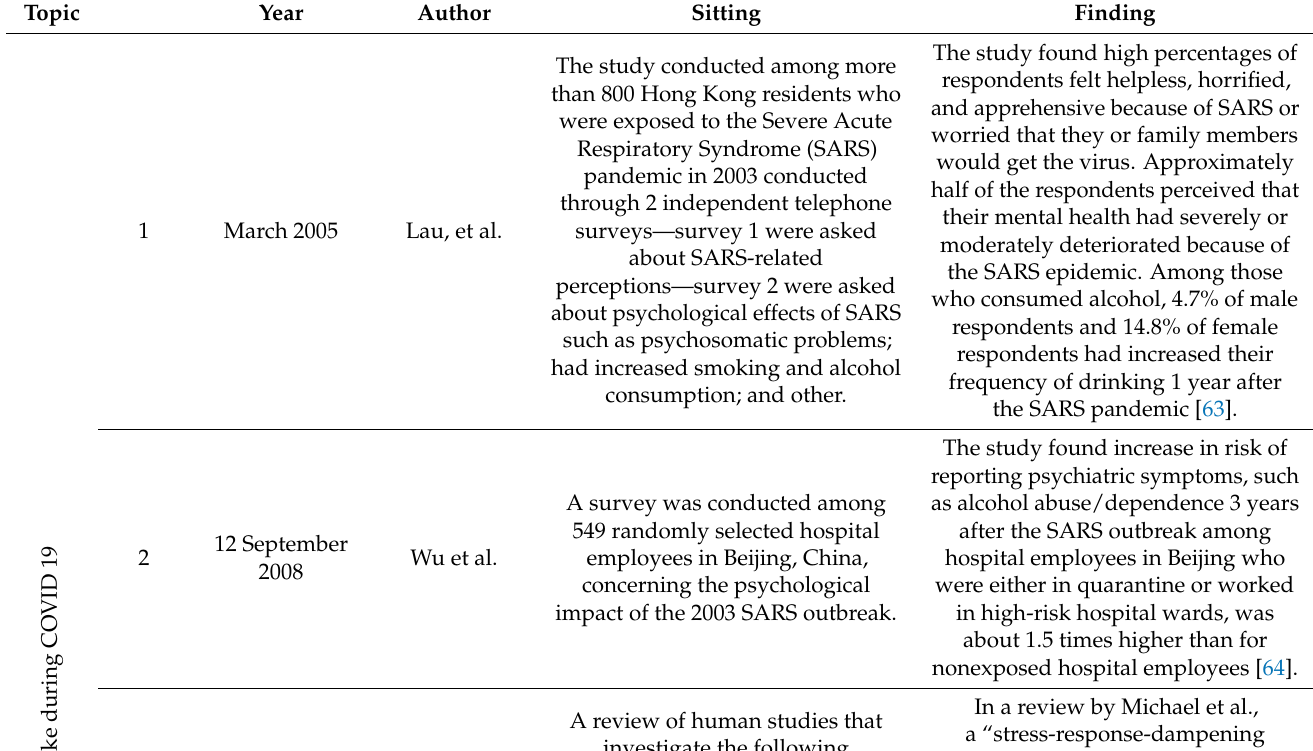
Table 2. Literature review of the possible scenarios of alcohol consumption behavior during the COVID19 pandemic.